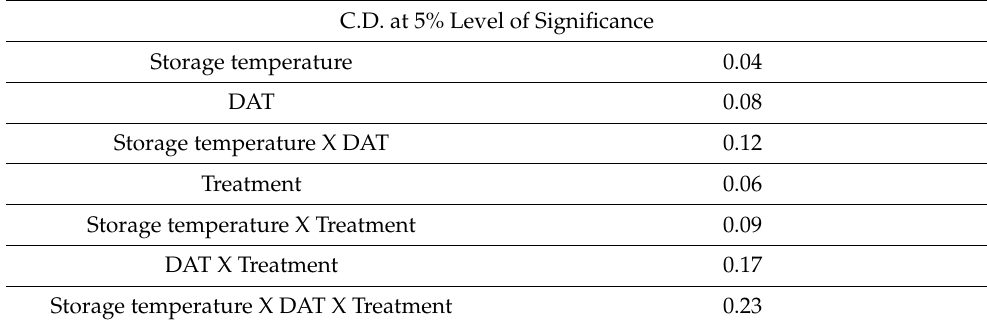
Figure 6. Effect of nanoformulation coatings on fruit firmness (kg/cm 2 ) of Hisar Surkha at ( a ) 25 ± 2 °C and ( b ) 32 ± 2 °C during storage.